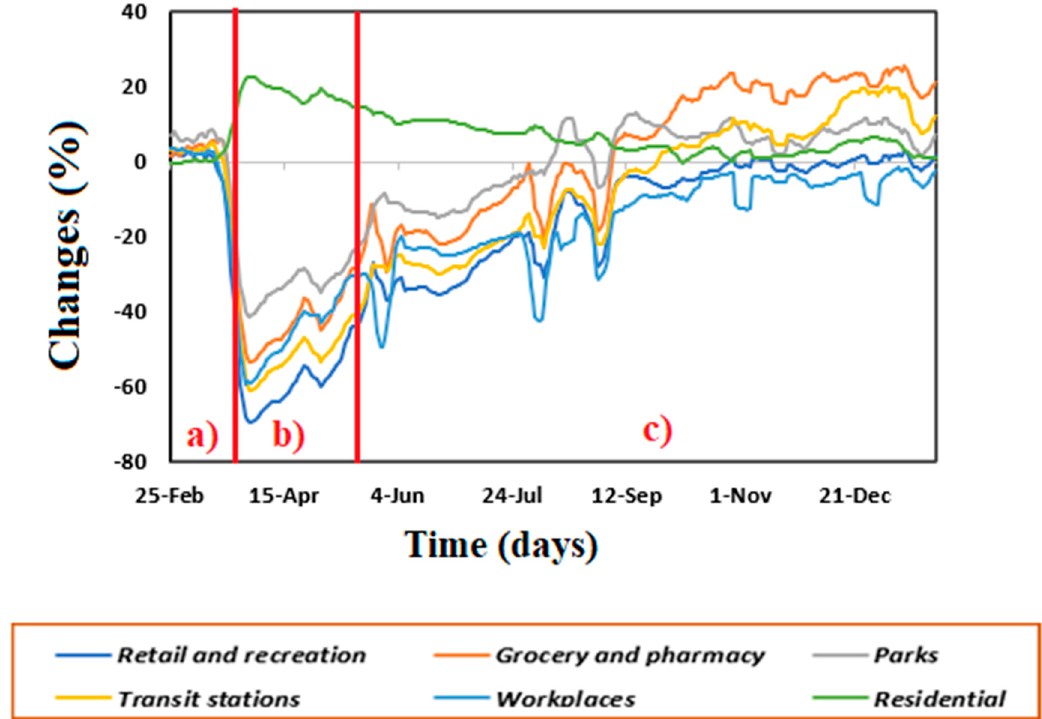
Figure 3. Urban mobility changes: ( a ) Before lockdown, ( b ) Strict lockdown, and ( c ) Loosening lockdown in Pakistan during the period Feb 2020–Feb 2021.